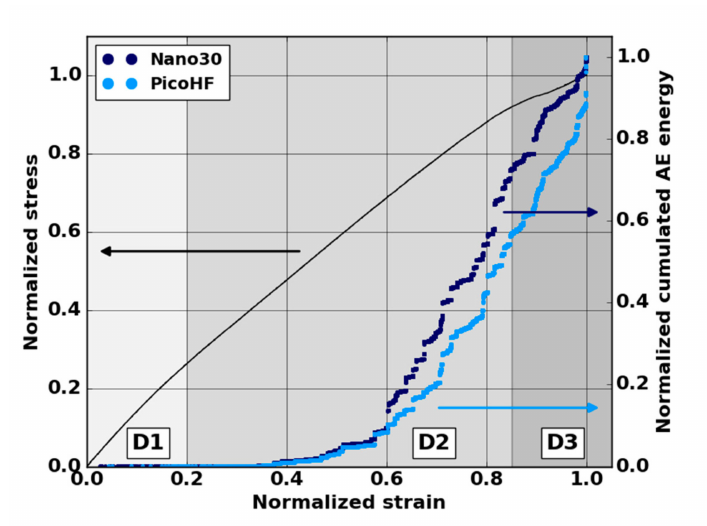
Figure 9. Stress-strain curve and global AE activity in terms of normalized cumulated AE energy during a macroscopic tensile test in the fiber orientation obtained from Nano30 and PicoHF sensors.